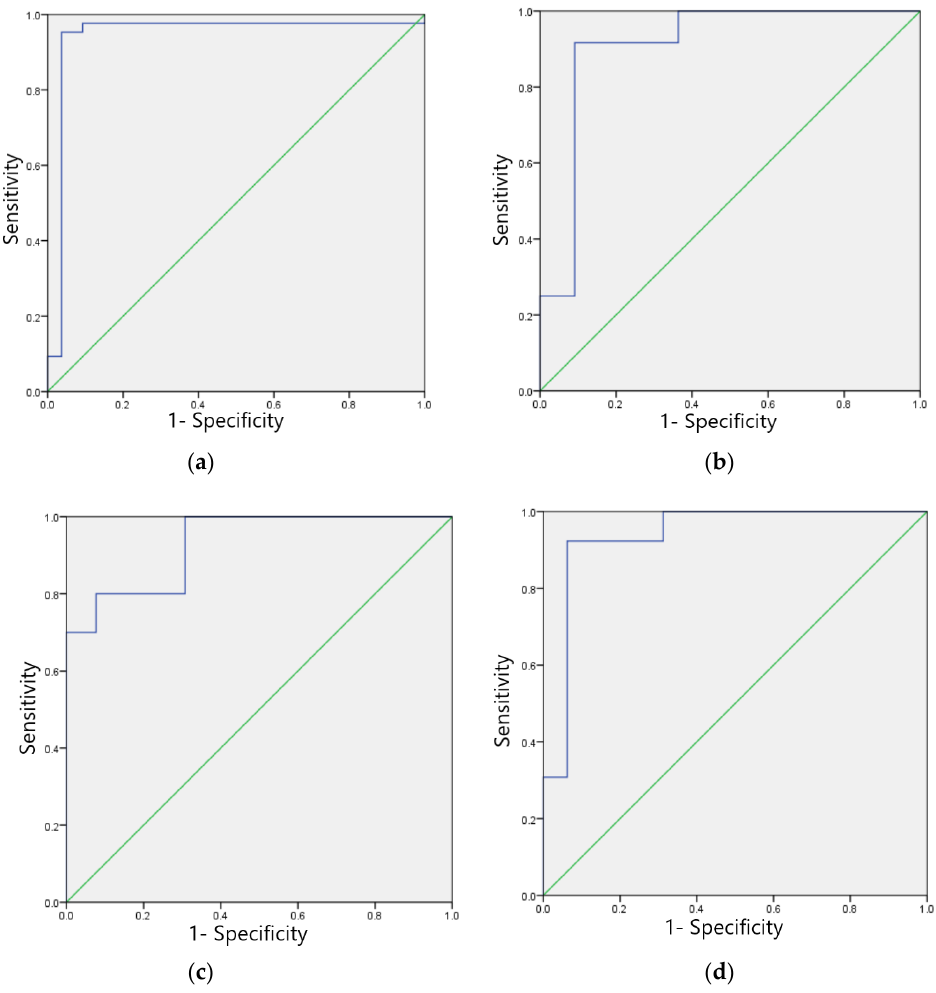
Figure 9. ROC curves of the verification set of four typical anomaly categories: ( a ) Sinus bradycardia; ( b ) Sinus tachycardia; ( c ) Myocardial ischemia; ( d ) Nonspecific intraventricular conduction delay. Table 9. Evaluation of the effect of ECG category identification validation set.